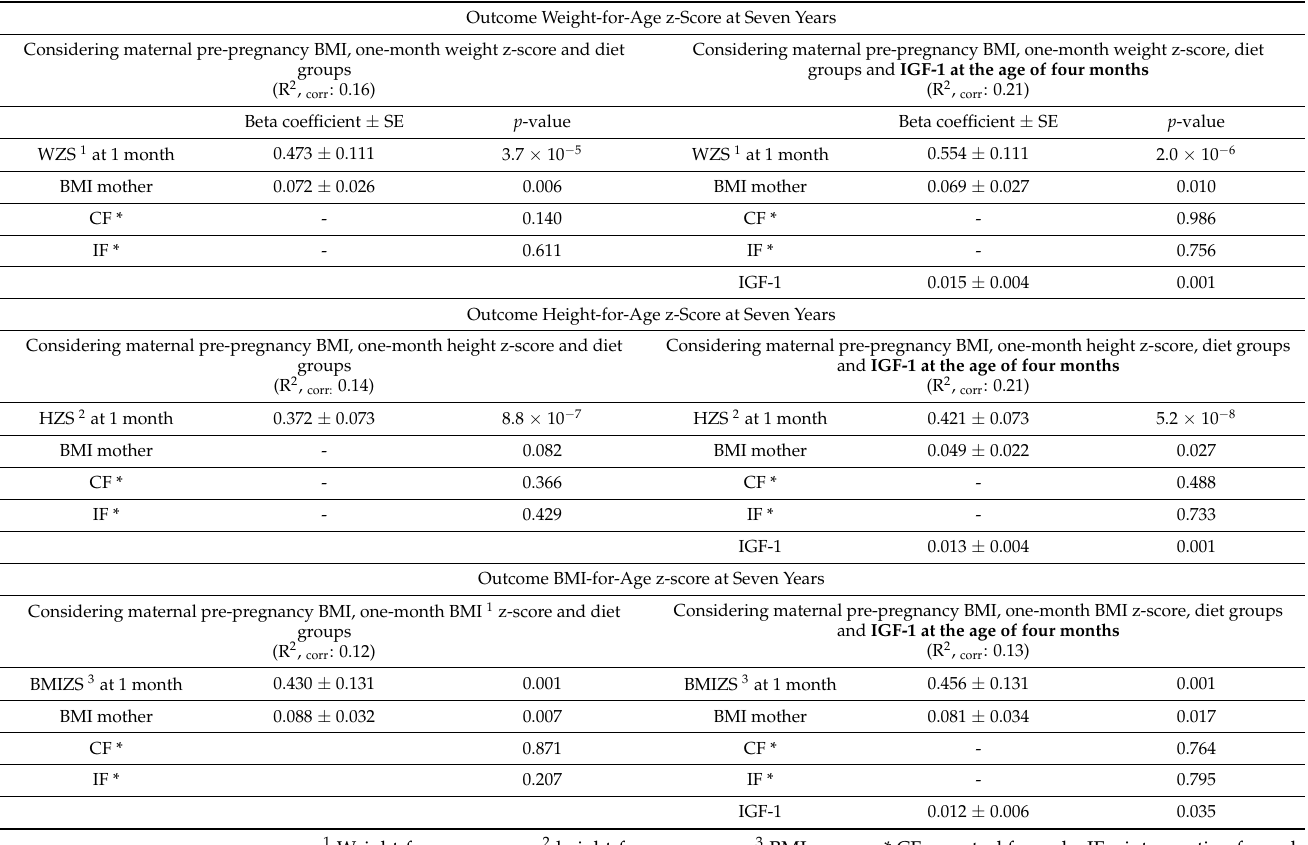
Table 5. Linear regression models that describe the association between the anthropometry z-scores at the ages of one month and seven years after considering the effects of diet groups in the main study, maternal pre-pregnancy BMI and IGF-1 levels at four months of